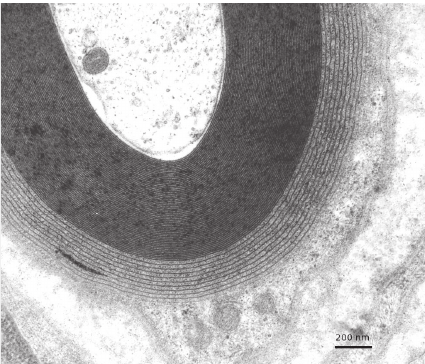
Figure 1: Typical widening of the most external myelin lamellae. Electron micrograph. Transverse section.